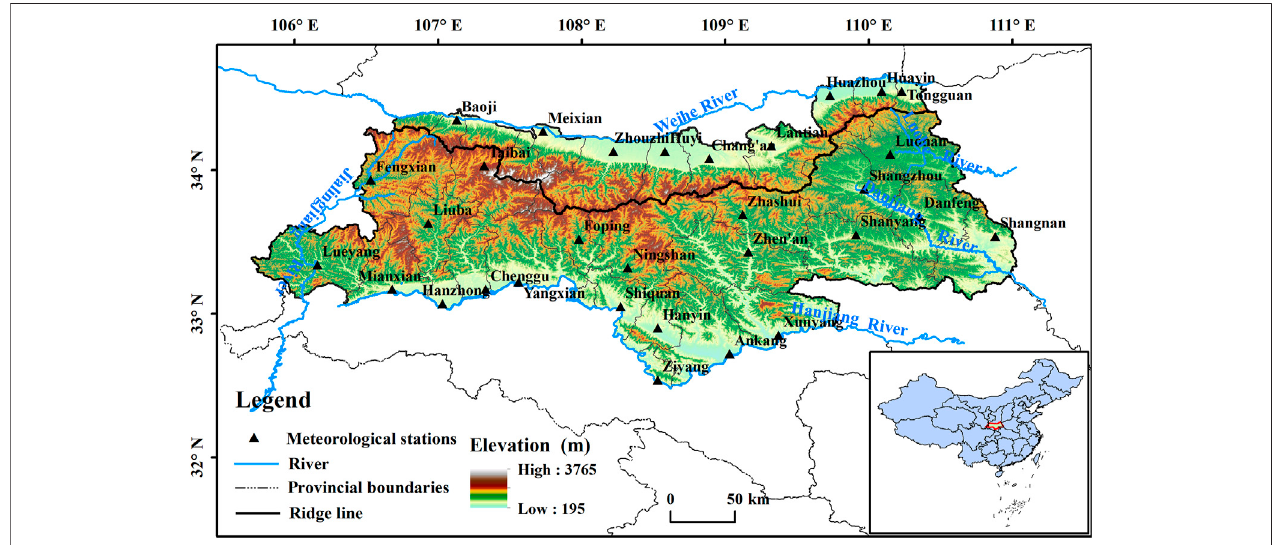
FIGURE 1 | Location of meteorological stations in the study